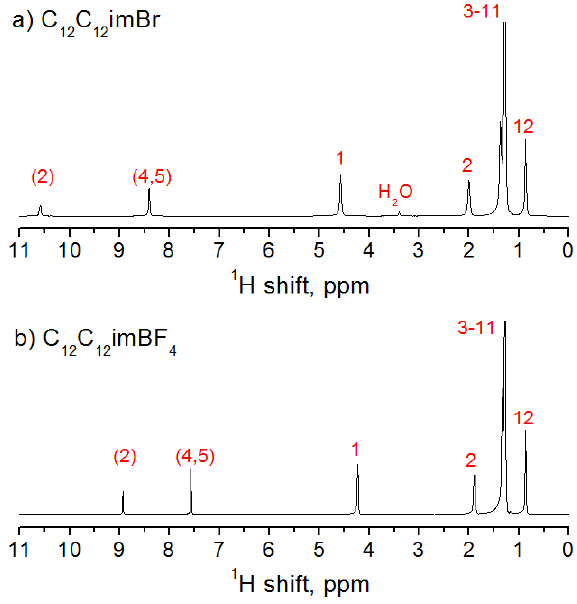
Int. J. Mol. Sci. 2020 , 21 , x FOR PEER REVIEW Figure 1. 1 H NMR spectra of C 12 C 12 imBr ( a ) and C 12 C 12 imBF 4 ( b ) in the isotropic phase at 123 °C. Figure 1. 1 H NMR spectra of C 12 C 12 imBr ( a ) and C 12 C 12 imBF 4 ( b ) in the isotropic phase at 123 ◦ C. Figure 1. 1 H NMR spectra of C 12 C 12 imBr ( a ) and C 12 C 12 imBF 4 ( b ) in the isotropic phase at 123 °C.